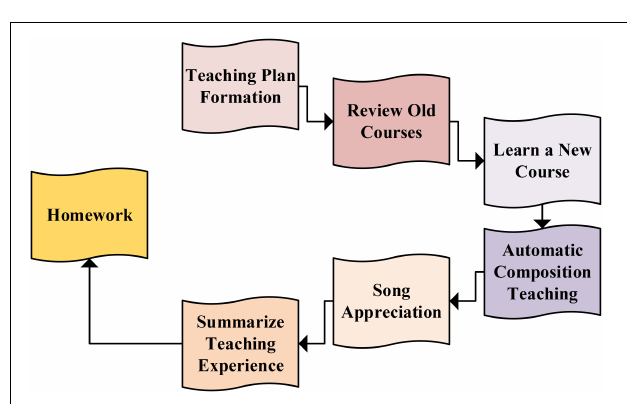
FIGURE 7 | Teaching process using the established ballad creation